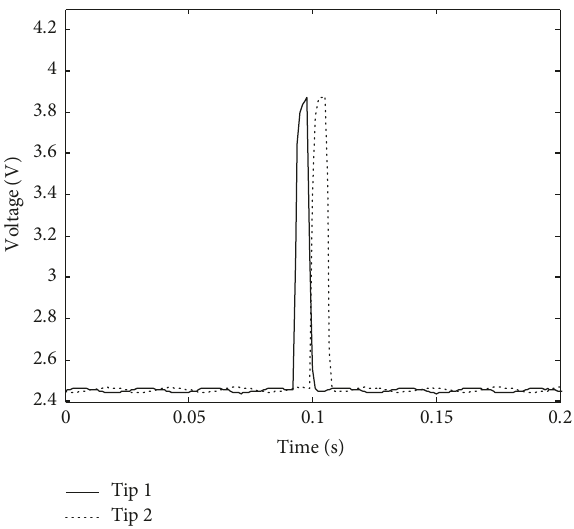
Figure 16: Time lag of the output signal for a single bubble.